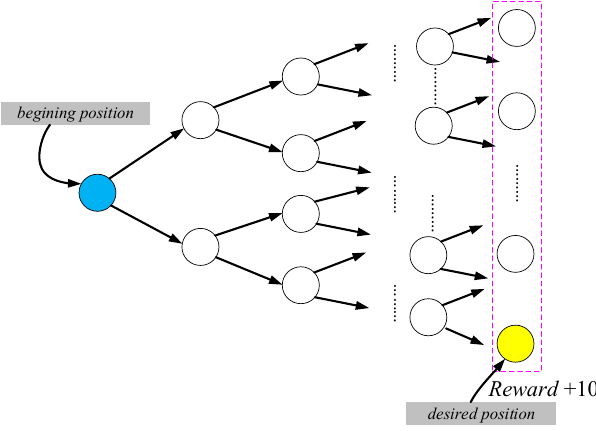
Figure 8. The experiment for robot migration.